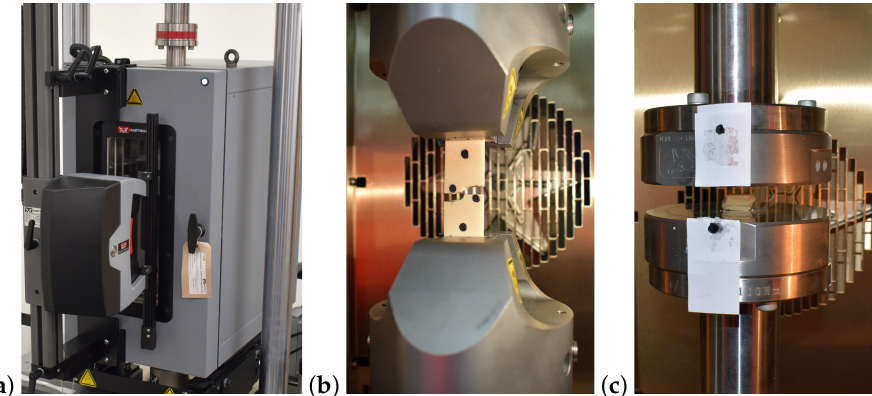
Figure 1. ( a ) Testing setup with heating chamber and video extensometer, ( b ) a test sample for the tension test, and ( c ) a test sample for the compression test.